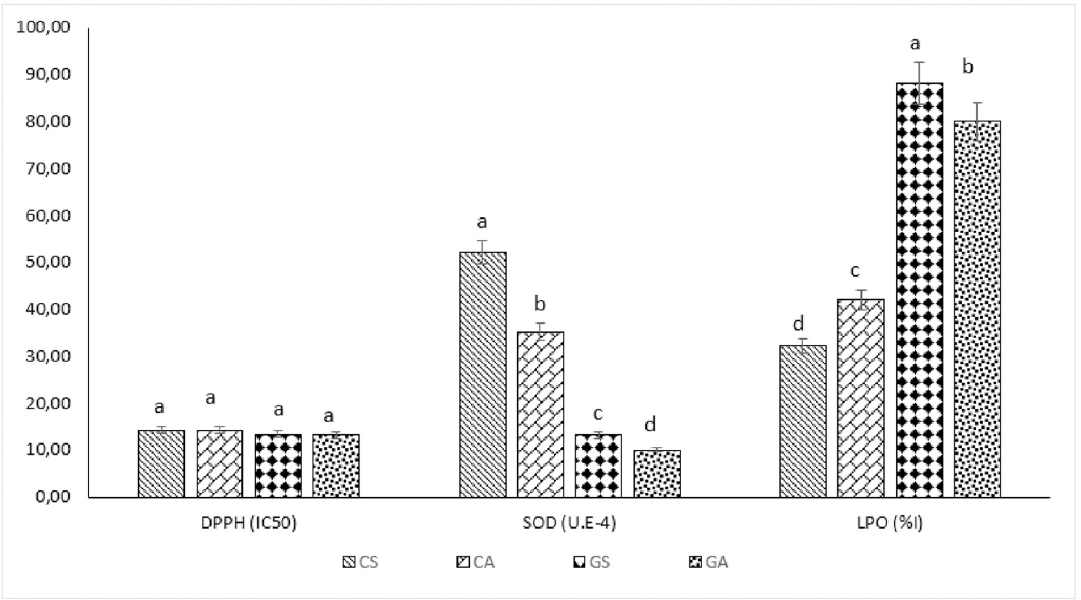
Fig 4. Antioxidents activities of extract Hibiscus sabdariffa . Values with similar letters within row are not significantly different at p �